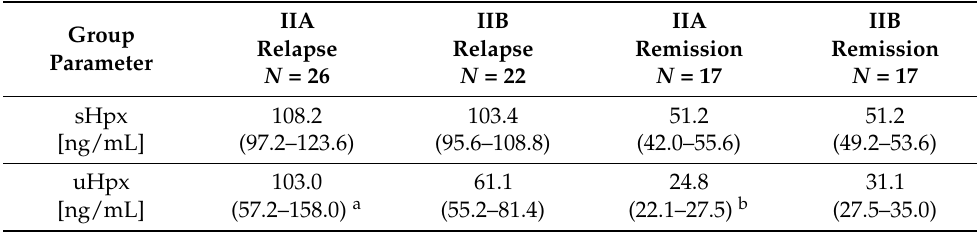
Table 4. sHpx and uHpx levels in the patient groups according to the treatment modality